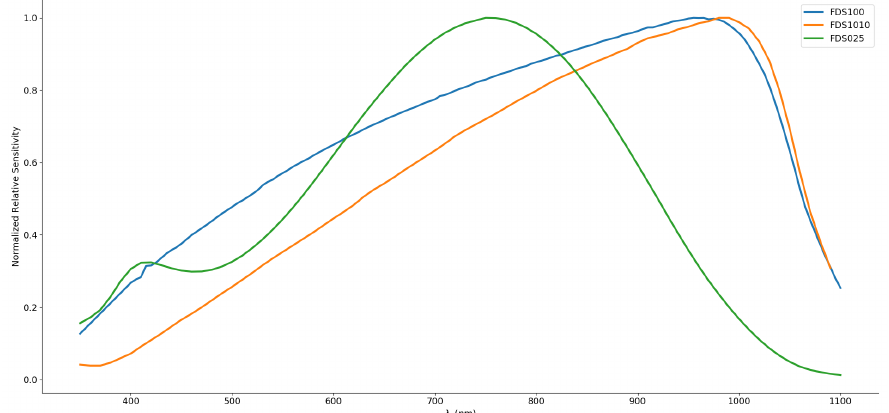
Figure 7. Normalized real sensitivity spectra of three commercial photodetectors (FDS100, FDS1010 and FDS025), adapted from